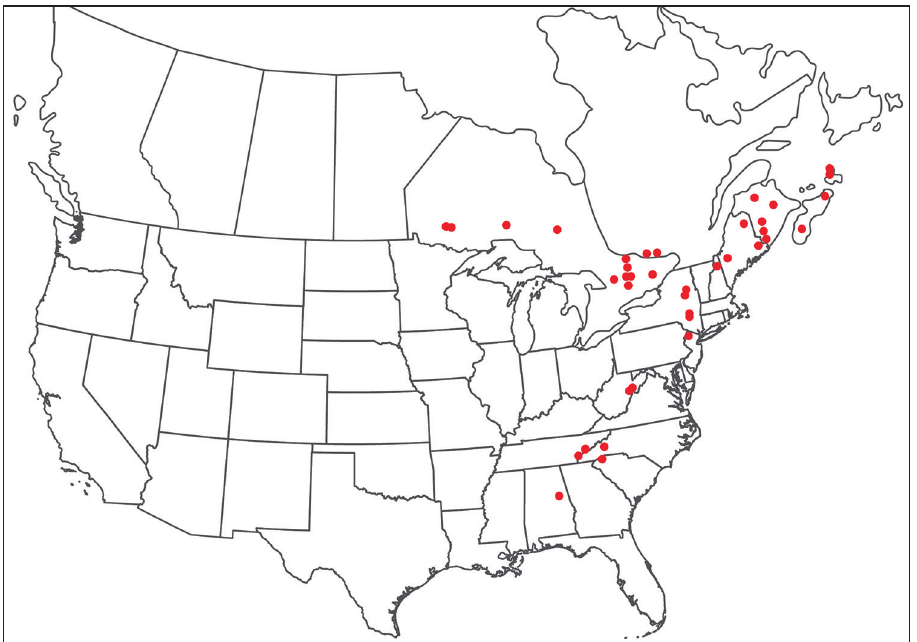
Figure 211. Torrenticola raptor sp. n.